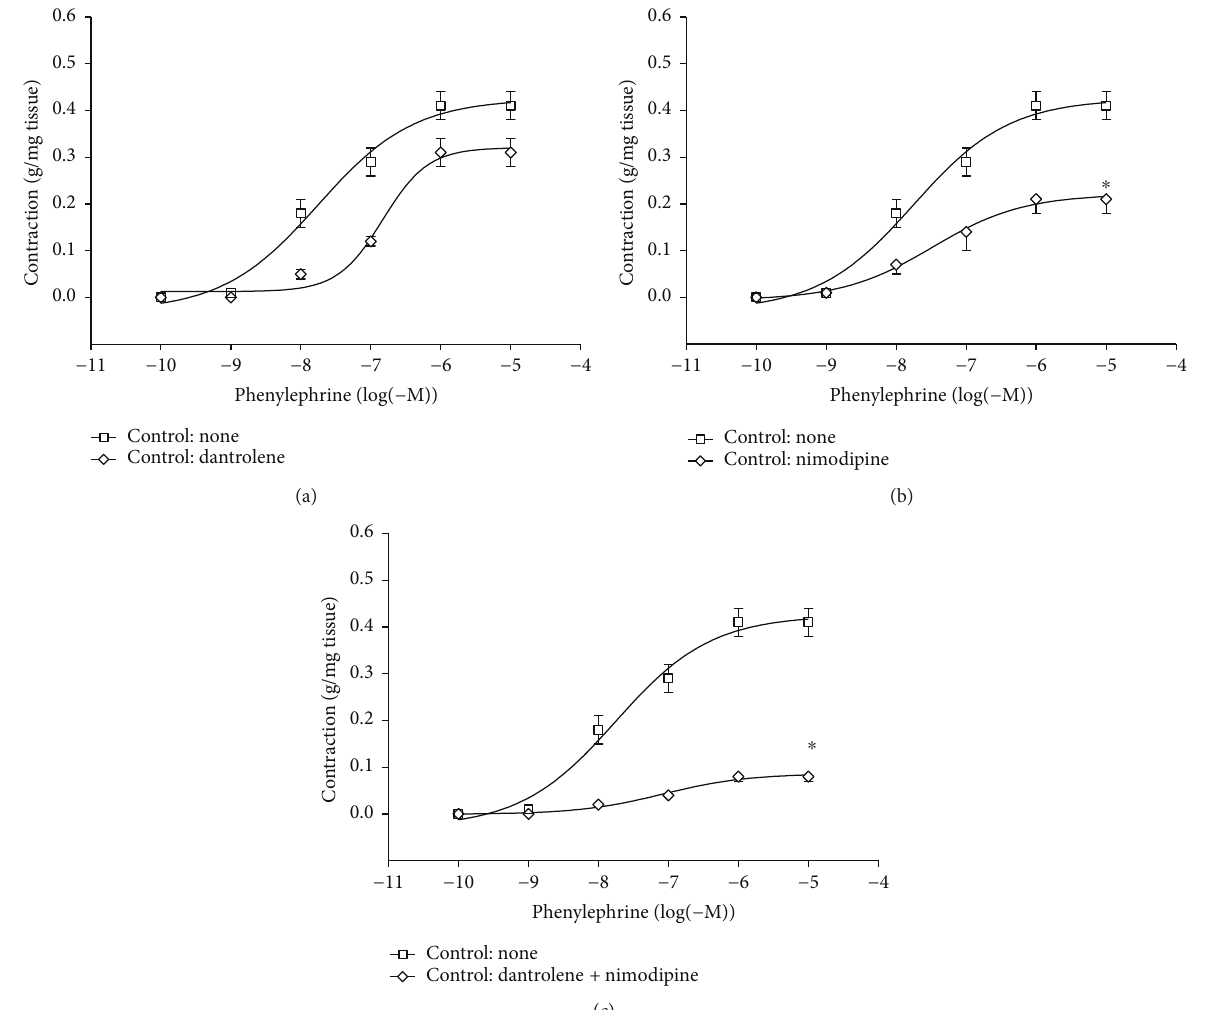
Figure 1: Cumulative concentration-response curves (from 0.1nM to 10 μ M) for the phenylephrine- (PHE-) induced contraction of aortic rings from control rats (CT) only before and after a 30 min incubation period with 50 μ M dantrolene (a), with 50nM nimodipine (b), and with both drugs in combination (c). The values shown are the means ± SEM of 6 to 9 animals per group. ∗ P < 0 05 , when comparing E before and after incubation with nimodipine and with dantrolene and nimodipine in